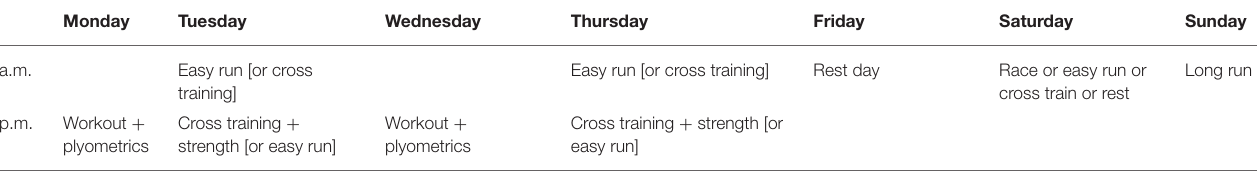
TABLE 2 | Example of a typical training week prescribed by the team head